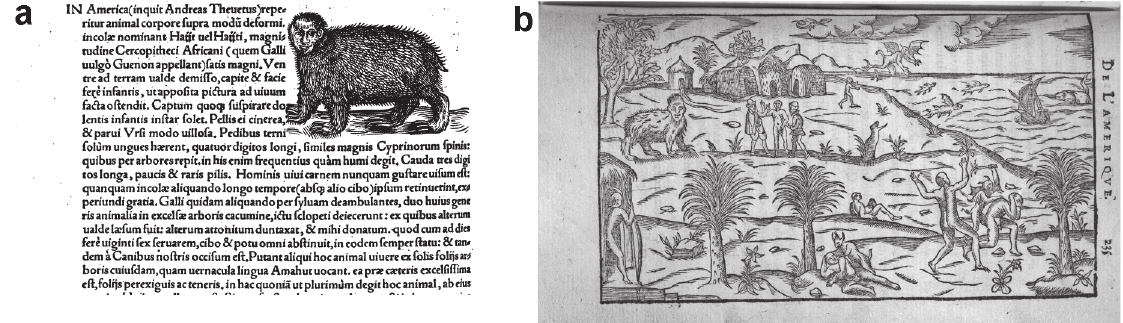
Figure 3 - (a) Haüt or Haüti . iconography present in Icones animalium quadrupedum viviparorum et oviparorum from Conrad gesner (1560, p. 96). Public Domain: http://books.google.com. (b) Hay . Sloths on the ground and on the tree, flying fishes, and demons tormenting humans. Iconography in Jean de Lery’s book Histoire d’vn Voyage fait en la Terre dv Bresil (1580, p. 235). Courtesy of the John Carter Brown library at Brown